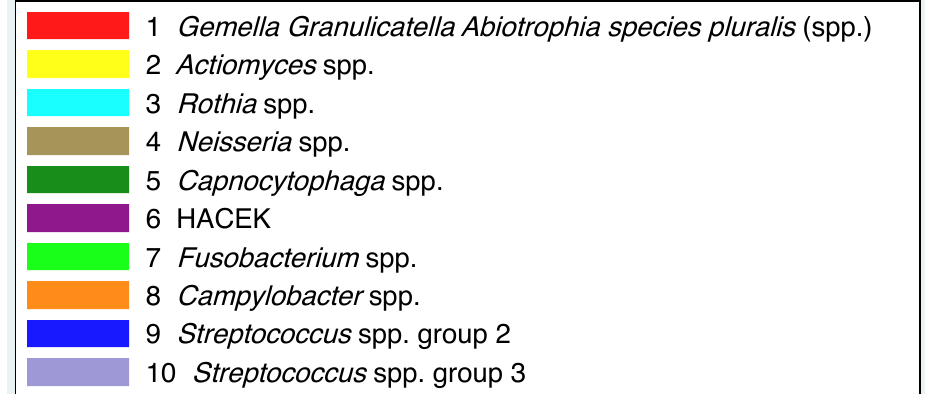
Figure 1. Bacterial groups and colour scheme for all